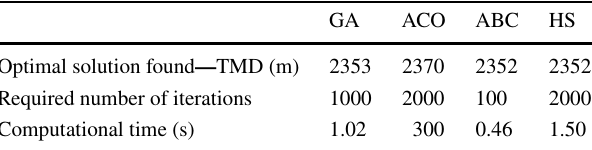
Table 6 Comparative results of tuned metaheuristic algorithms applied to the wellbore optimization Case